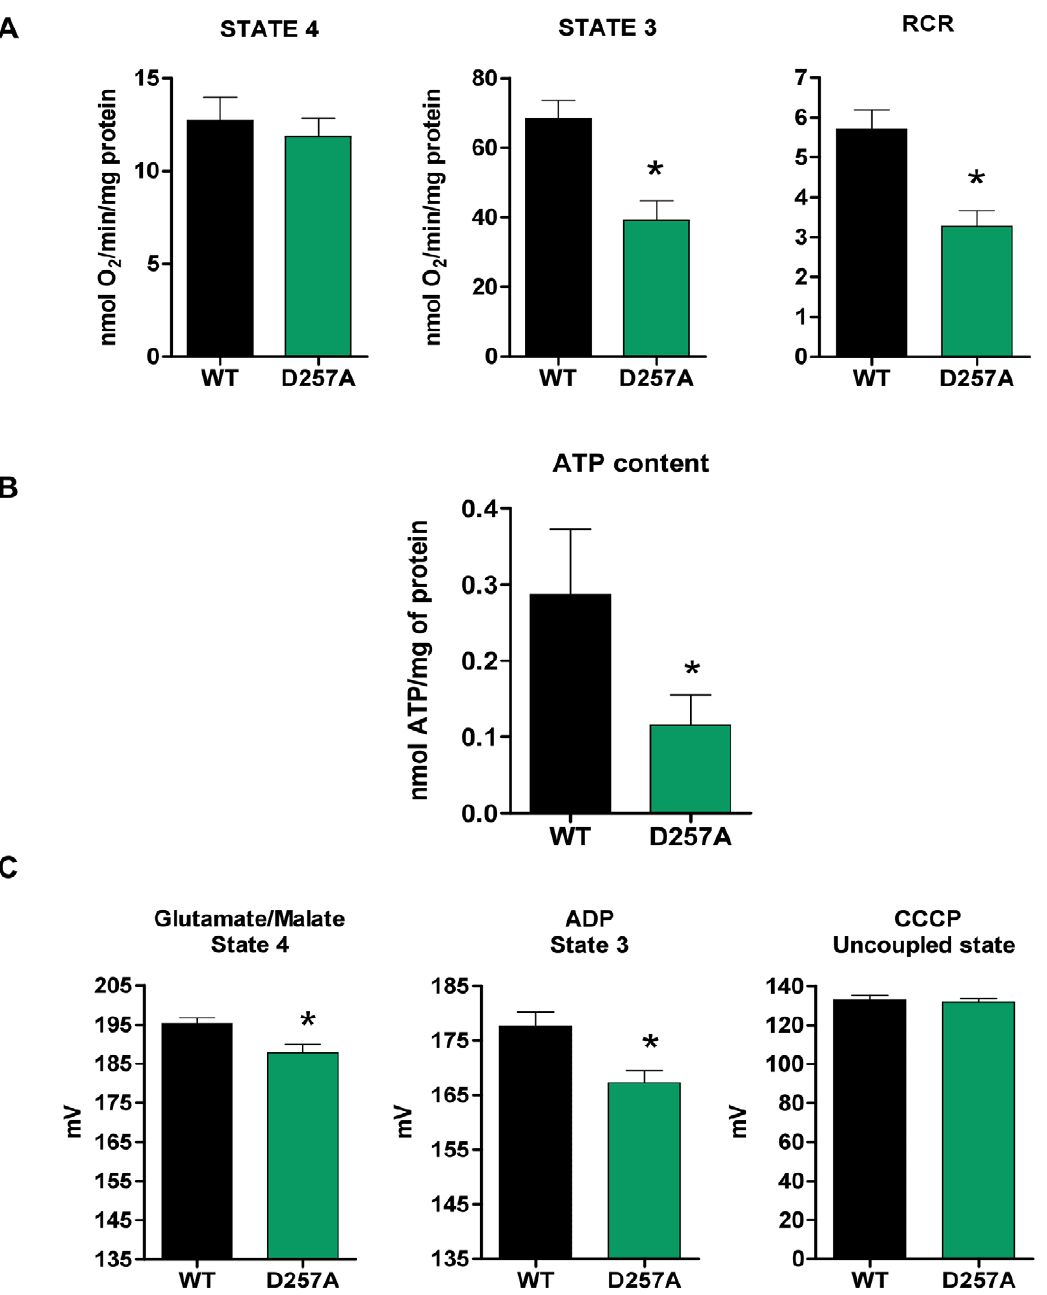
Figure 7. Mitochondrial bioenergetics is compromised in D257A skeletal muscle leading to a drop in mitochondrial Dy m . (A) We determined the effects of mtDNA mutations on O 2 consumption of skeletal muscle mitochondria obtained from 11-mo old WT and D257A mice (n=11 per group). Oxygen consumption was measured during state 4 (non-phosphorylative state) with pyruvate/malate as substrate, and during state 3 (phosphorylative state) with the addition of ADP. The respiratory control ratio (RCR), an index of mitochondrial coupling and metabolic activity, was calculated by dividing state 3 by state 4 respiration values. Mean values 6 SEM are shown. *p , 0.001. (B) We evaluated ATP content in skeletal muscle mitochondria of 11-mo old WT (n=11) and D257A (n=8) mice using a luciferin-luciferase based bioluminescence assay. Mean values 6 SEM are shown. *p , 0.05. (C) Changes in Dy m were followed qualitatively by monitoring the fluorescence of TMRM that accumulates in energized mitochondria of 13-mo old WT and D257A mice (n=6 per group). Dy m was measured during both state 4 (non-phosphorylative state) with glutamate/malate as substrate and during state 3 (phosphorylative state) with the addition of ADP. Measurement of Dy m after addition of CCCP served as a control for TMRM loading in mitochondria. Mean values 6 SEM are shown. *p , 0.02.